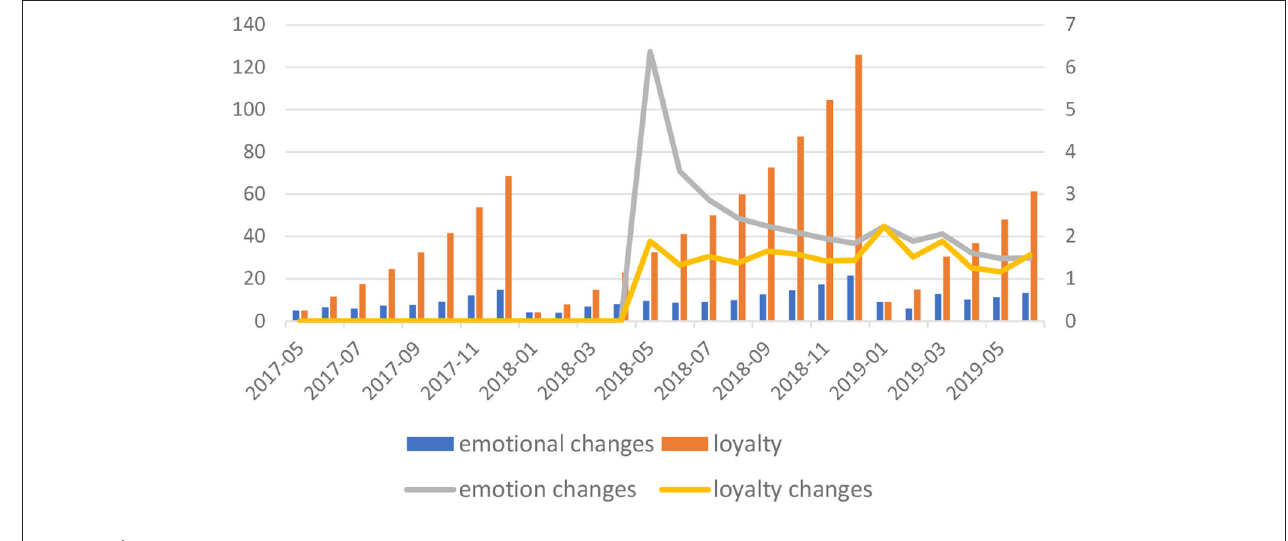
FIGURE 2 | Loyalty type identification.